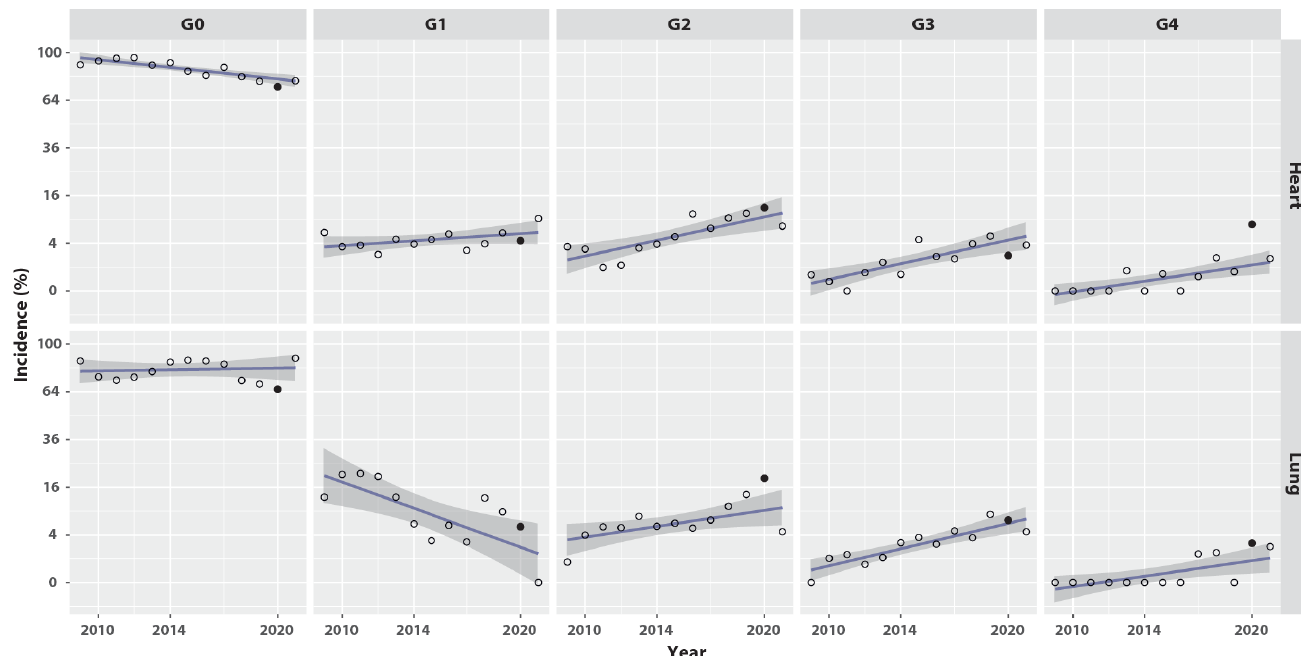
Figure 1. Rates of heart and lung toxicity grades over the calendar years. G0, no toxicity. G1–G4, toxicity Grade 1–4. Open circle: rate averaged on all patients observed in the year. Filled circle: rate observed in 2020, year of the COVID pandemic. Line: ordinary least squares fitted on years 2009–2021 excluding 2020. Grey band: 95% confidence interval of the least squares fit.